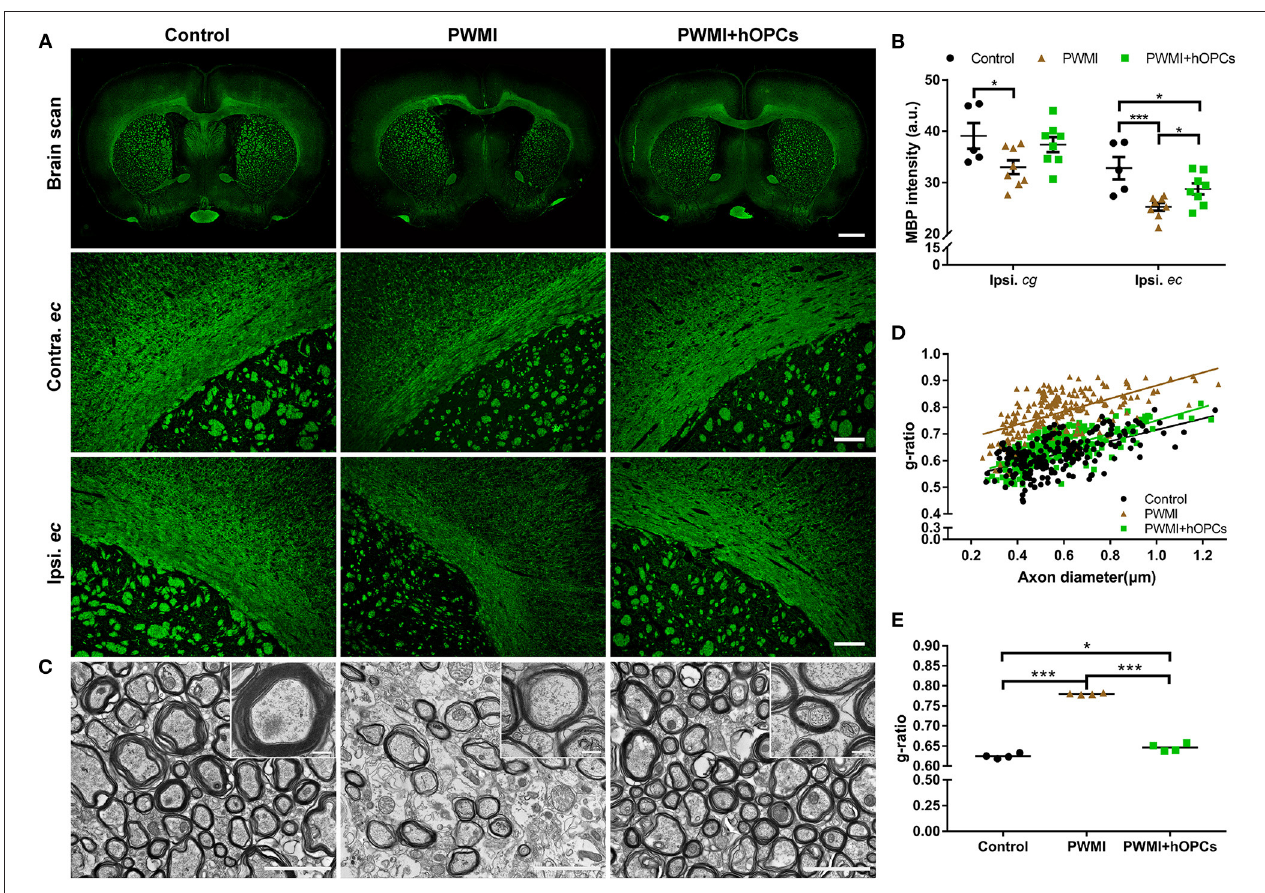
FIGURE 3 | Immunohistochemical and TEM analysis of myelin. (A) Representative images of MBP intensity in both hemispheres and external capsules at 13 weeks post-transplantation. Scale bar represents 2,000 µ m in the top row and 200 µ m in the two lower rows. (B) Quantification of MBP intensity in the ipsilateral cingulate gyrus ( cg ) and external capsule ( ec ) ( n = 5 for control, n = 8 for PWMI and PWMI + hOPCs; three sections per rat; one-way ANOVA with LSD for multiple comparisons). (C) Representative TEM images of myelin sheath in the corpus callosum. Scale bar represents 2 µ m in (C) and 200nm for the insert pictures. (D,E) G-ratios of myelinated axons in the corpus callosum of the control, PWMI, and PWMI + hOPCs groups ( n = 4 per group, one-way ANOVA with LSD for multiple comparisons). Data are presented as mean ± SEM. * P < 0.05, *** P <